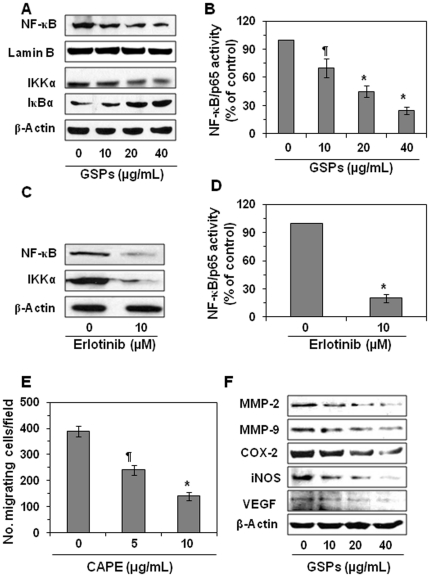
Effect of GSPs and erlotinib on NF-κB activation in OSC19 cells.(A) Treatment of OSC19 cells with GSPs decreases the basal levels of NF-κB/p65 and IKKα while inhibiting the degradation of IκBα. After treatment of cells for 48 h with various concentrations of GSPs the cells were harvested, cytosolic and nuclear fractions were prepared and these were subjected to western blot analysis. Representative blots are shown from three independent experiments with identical observations. (B) The activity of NF-κB/p65 in the nuclear fraction of cells after treatment with and without GSPs was measured using an NF-κB/p65-specific activity assay kit, n = 3. Activity of NF-κB/p65 is expressed in terms of percent of the control (non-GSPs-treated) group. Significant decrease versus control: ¶
P<0.05, *
P<0.001. (C) Similarly, treatment of OSC19 cells with erlotinib reduced the levels of NF-κB and IKKα. Representative blots are shown from two independent experiments. (D) The activity of NF-κB/p65 in the nuclear fraction of cells after treatment with and without erlotinib for 48 h was measured using the NF-κB/p65-specific activity assay kit, n = 2. Activity of NF-κB/p65 is expressed in terms of percent of control (non-erlotinib-treated) group. Significant decrease versus control: *
P<0.001. (E) Treatment of OSC19 cells with caffeic acid phenethyl ester (CAPE), an inhibitor of NF-κB, for 48 h inhibited cell invasion in a concentration-dependent manner. Data on cell invasion are summarized as the mean number of invasive cells±SD/microscopic field from three independent experiments, magnification: ×10. Significant inhibition versus non-CAPE-treated cells, *
P<0.001, ¶
P<0.05. (F) GSPs reduce the levels of NF-κB-targeted proteins, such as MMP-2, MMP-9, COX-2, iNOS and VEGF, in OSC19 cells. After treatment of cells with and without GSPs for 48 h, cells were harvested, and cell lysates were subjected to the analysis of the levels of proteins using western blot analysis. Representative blots are shown from three independent experiments.